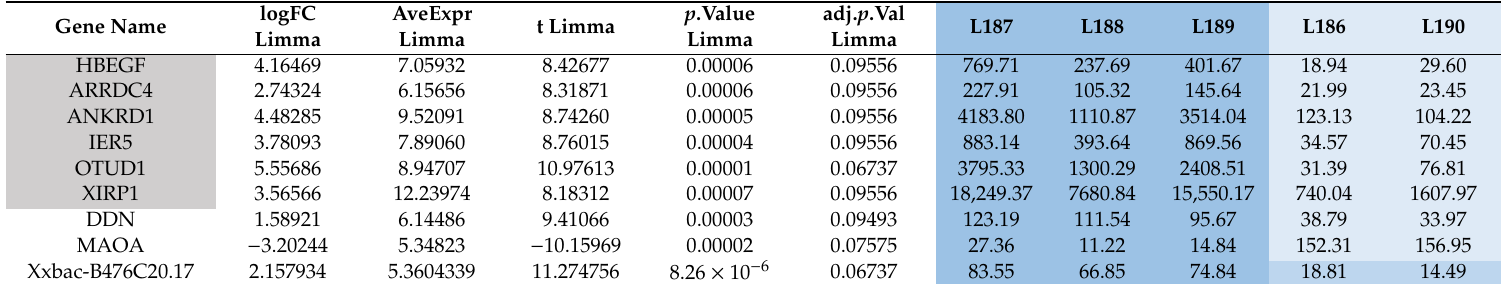
Table 6. Genes responsible of the wrong assignment of the ET subjects to their group (shaded genes are also in Table